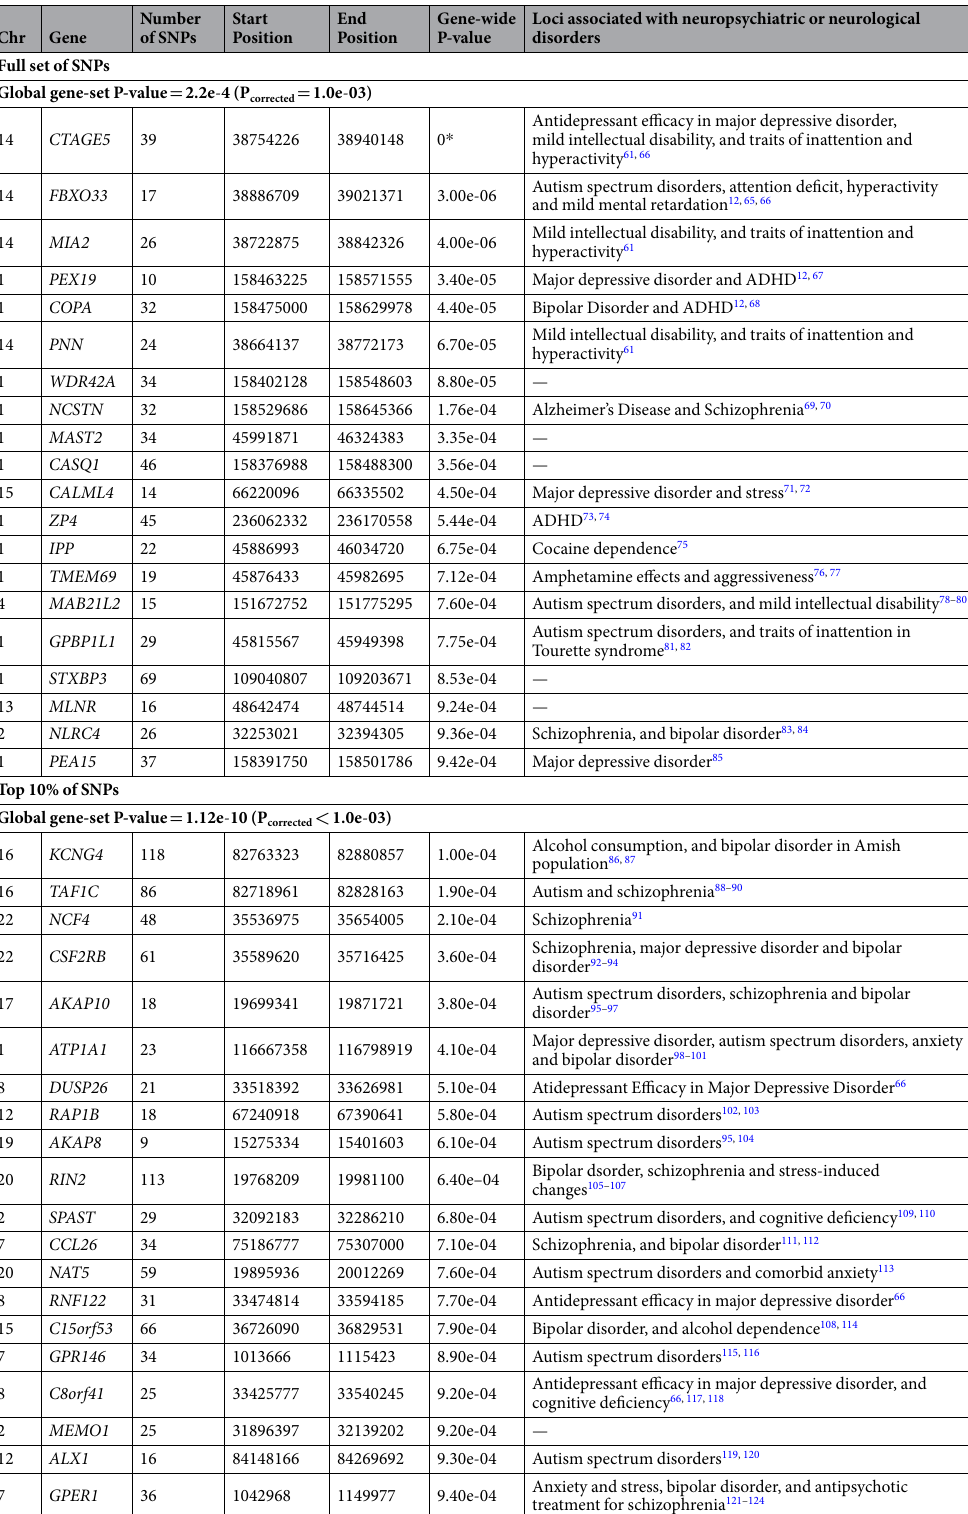
Table 1. Gene-wide and gene-set P-values considering all SNPs or the 10% most significant SNPs in gene locus using VEGAS and MAGMA softwares. Genes displaying P-value < 1e-03 are shown. Start and end positions include default flanking regions of ± 50 Kb from 5 ′ and 3 ′ UTRs of each gene, defined by default by VEGAS software (http://gump.qimr.edu.au/VEGAS/), and are based on UCSC annotation, build NCBI36/hg18 (Mar. 2006). * An empirical P-value of 0 (from 10 6 simulations) can be interpreted as P-value < 10 6 , which exceeds